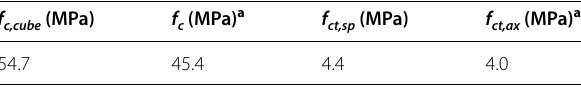
Table 2 Specimens H50-s1 and H50-s2 under shear: experimental values of concrete mechanical properties.